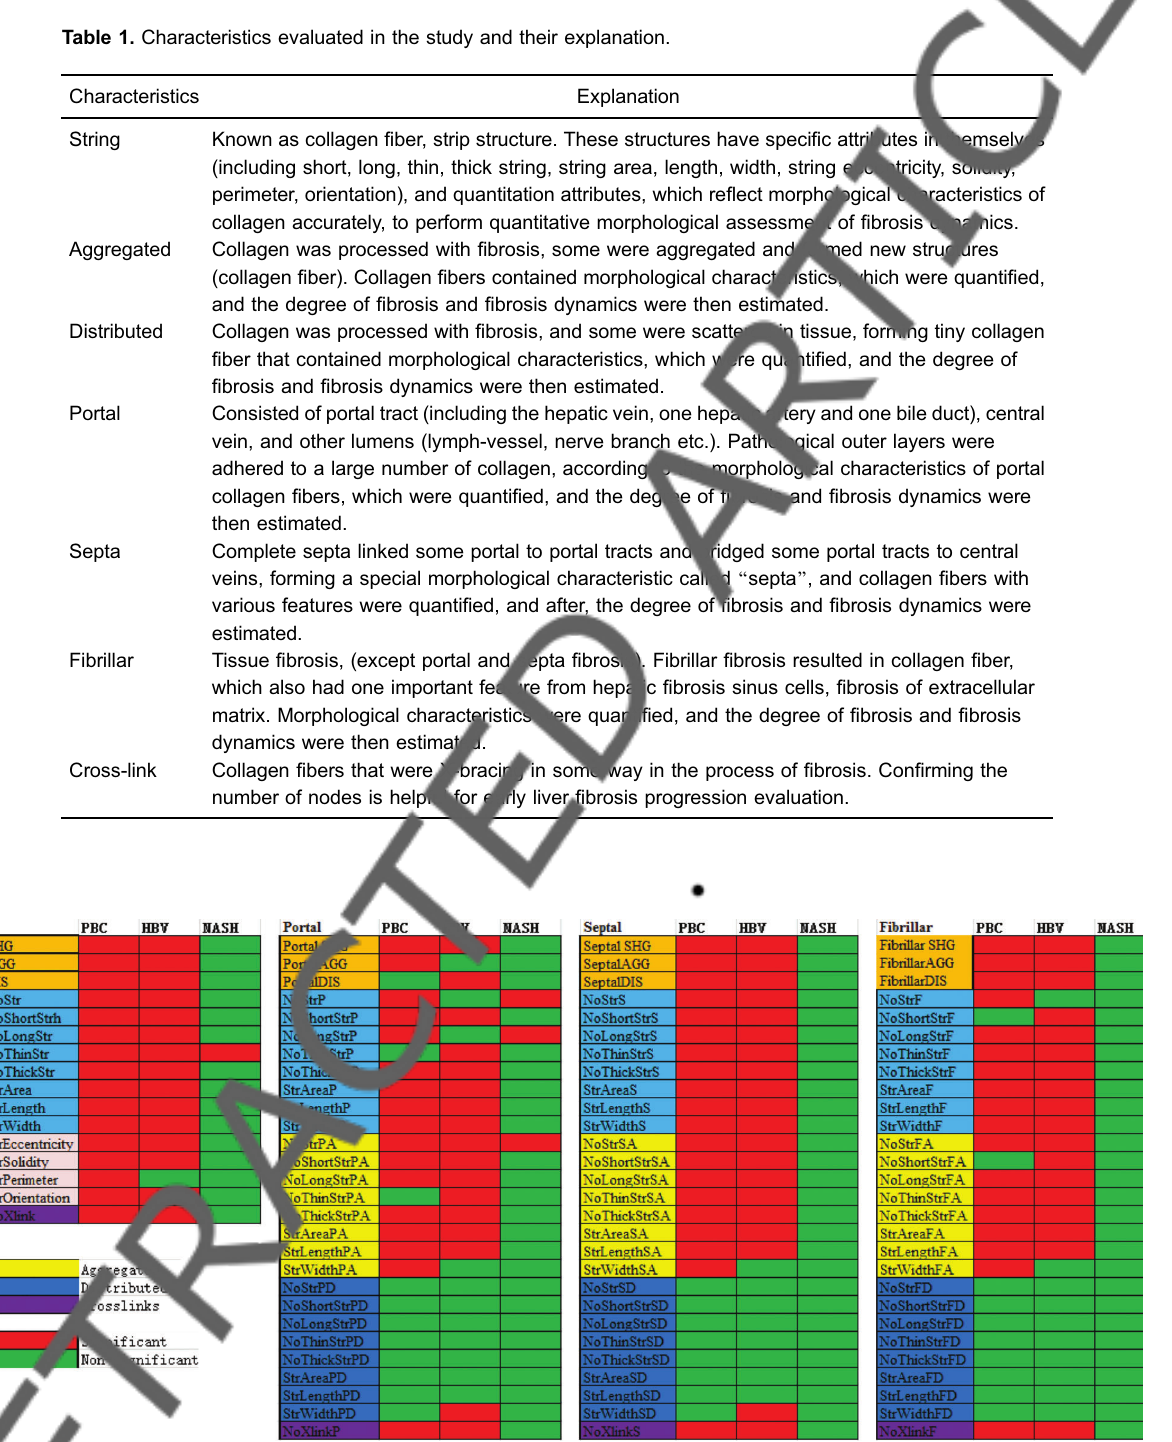
Braz J Med Biol Res | doi: